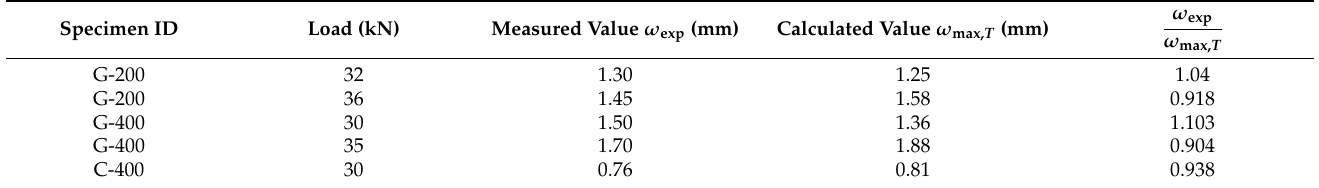
Table 6. Comparison between measured and calculated values of maximum crack width of tested beam specimens after high-temperature